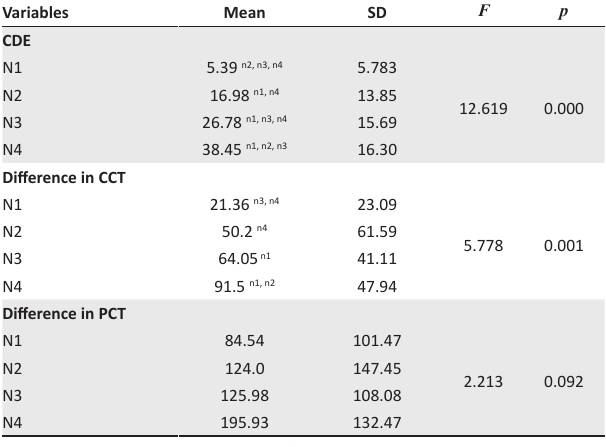
TABLE 9: Comparison between cumulative dissipated energy, pre- and post- operative differences in central and peripheral corneal thickness amongst grades of nuclear cataract.